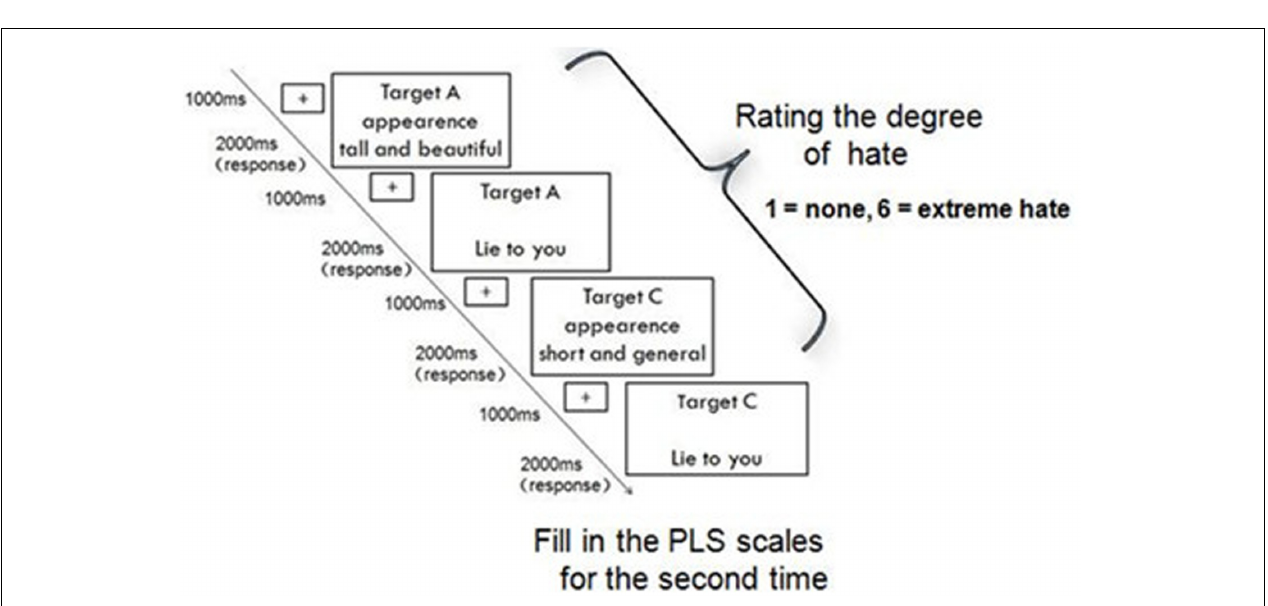
FIGURE 2 | Part 2 consisted of two phases: rating on the computer and completing the PLS. This figure presents a schematic depiction of the stimuli and rating task design of Part 2 ( hate ). Specific traits of Lover A, Lover B, and Lover C were presented as in Part 1. Each trait was followed by a subsequent negative event, which was presented for 2000 ms or until response. The top line indicated a target person, and the bottom line indicated a negative event. A 1000 ms inter-stimulus interval was interleaved between each trait and negative event.